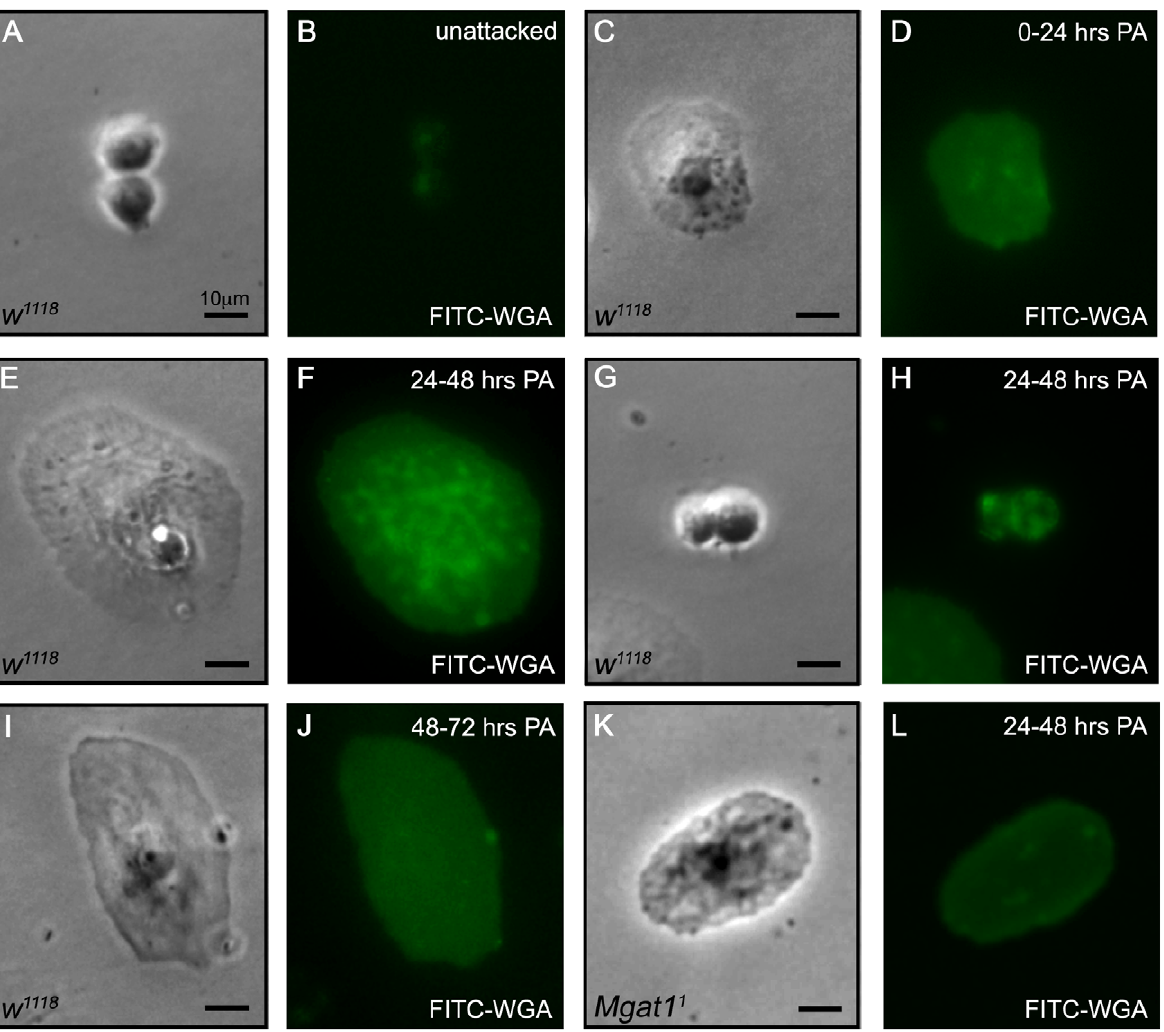
Figure 1. N-glycosylation of hemocytes is temporally specific following wasp attack. Paired brightfield and FITC images of hemocytes stained with FITC-WGA at the indicated time after wasp attack reveals that WGA staining of hemocytes is dynamic following wasp attack. (A,B) Plasmatocytes from unattacked w 1118 larvae, age matched with the 24–48 hour post attack (PA) time point, did not stain with WGA. (C,D) At 0– 24 hours PA, lamellocytes from L. clavipes attacked w 1118 larvae began to show WGA staining. (E–H) A strong, speckled, WGA staining pattern was seen in lamellocytes (E,F), and to a lesser extent, plasmatocytes (G,H) from attacked w 1118 larvae at 24–48 hours PA. (I,J) By 48–72 hours PA, lamellocytes from attacked w 1118 larvae no longer stained with WGA. (K,L) Lamellocytes from attacked Mgat1 1 mutant larvae did not stain with WGA at 24–48 hours PA, demonstrating that the WGA signal is dependent on N-glycosylation pathway function. Scale bar in all panels indicate 10 m m.